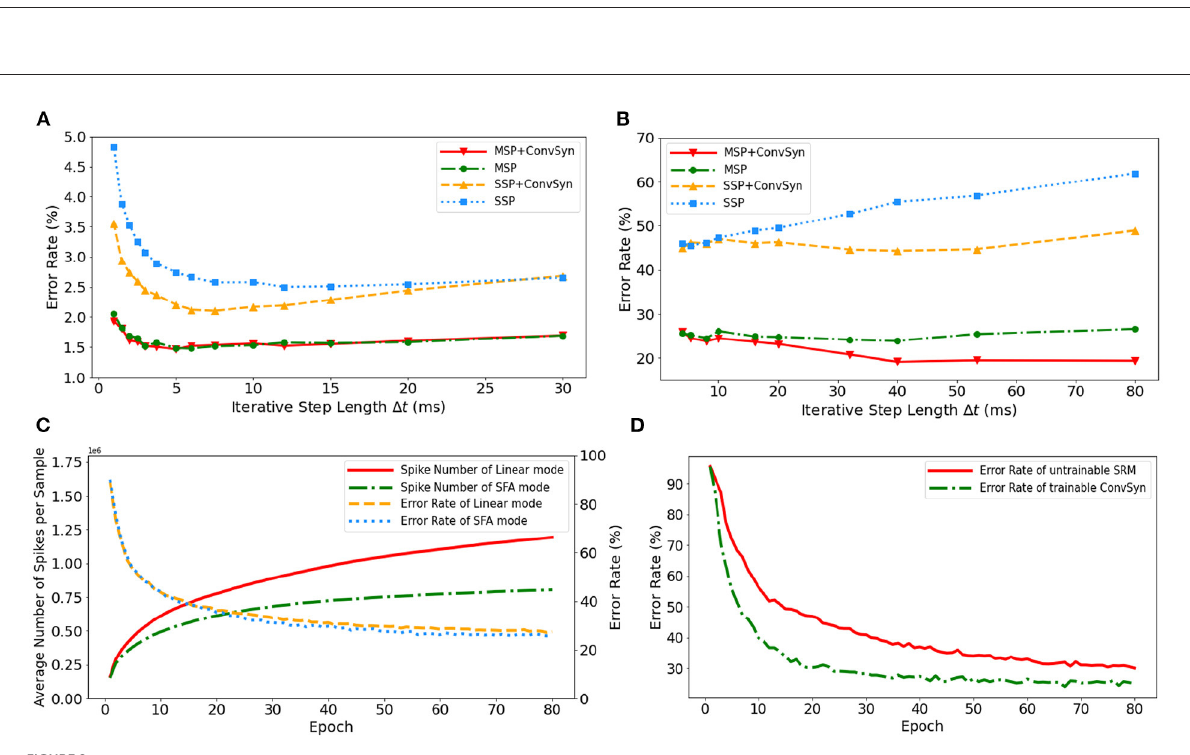
FIGURE9 Experimental results. (A) Error rate curves among different iterative step lengths on N-MNIST. (B) Error rate curves among different iterative step lengths on SHD. (C) Control experiment of spike frequencies between SFA and Linear modes on SHD. (D) Control experiment of synaptic plasticity for performance improvement on